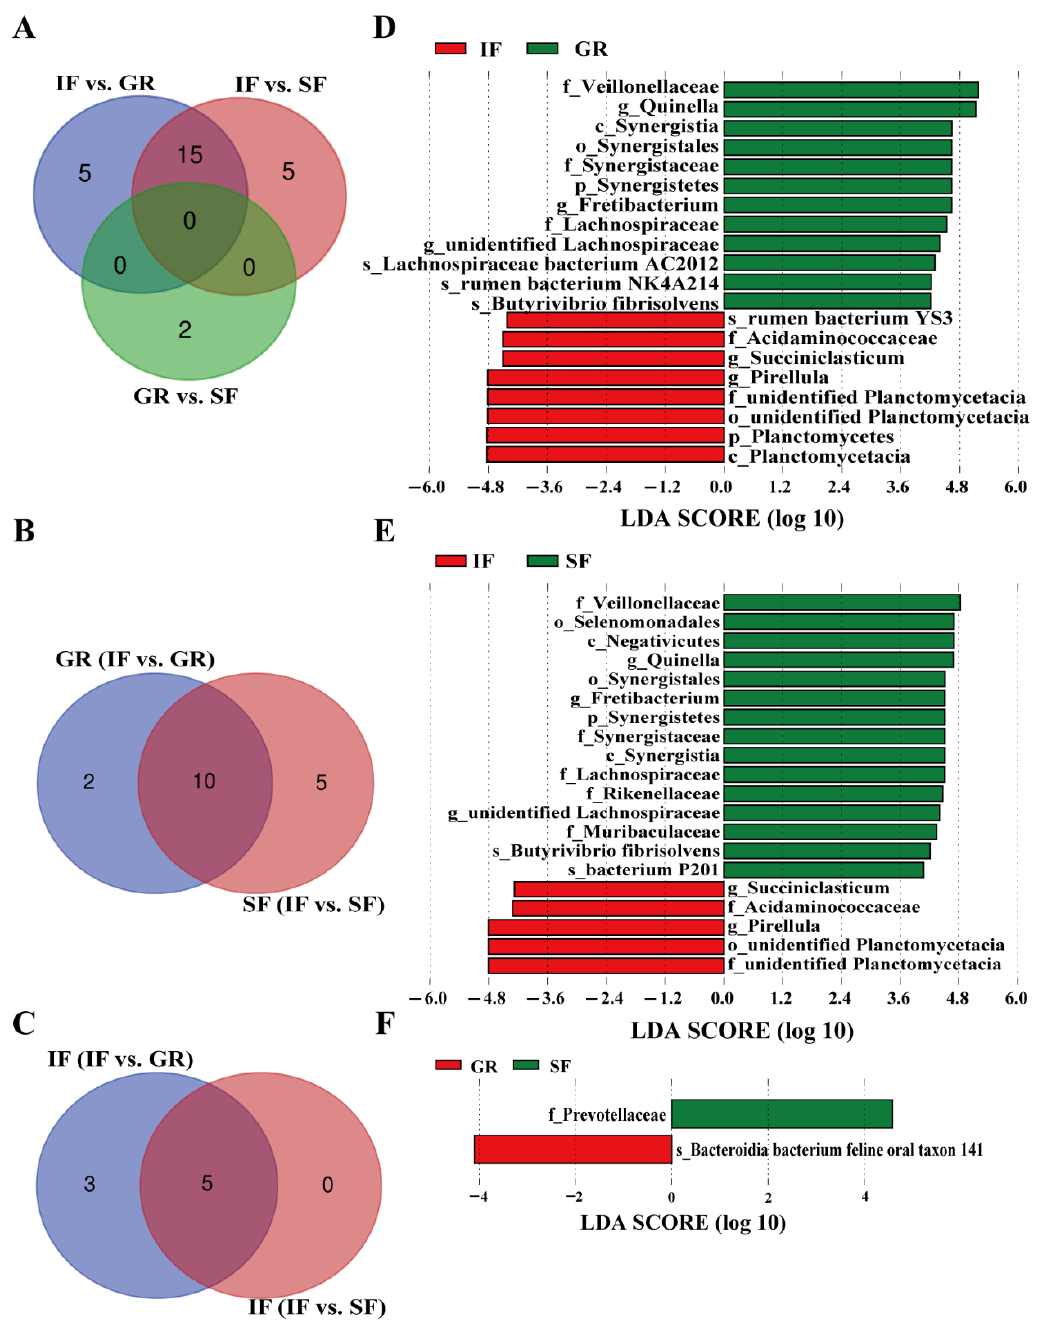
Figure 3. Bacterial taxa with significantly different abundances in each of the three feeding systems based on pairwise comparisons using linear discriminant analysis effect size (LEfSe) (linear discriminant analysis (LDA) score > 4 and p < 0.05). ( A ) Number of common and unique biomarkers between pairwise comparisons of the three feeding systems; ( B ) number of common and unique biomarkers in the supplementary feeding (SF) and shrub-grassland grazing (GR) groups based on the pairwise comparisons of GR vs. indoor feeding (IF) and SF vs. IF; ( C ) number of common and unique biomarkers in the IF group based on the pairwise comparisons of GR vs. IF and SF vs. IF; ( D ) the bacterial biomarkers identified in the pairwise comparison between GR and IF; ( E ) the bacterial biomarkers identified in the pairwise comparison between SF and IF; ( F ) the bacterial biomarkers identified in the pairwise comparison between GR and